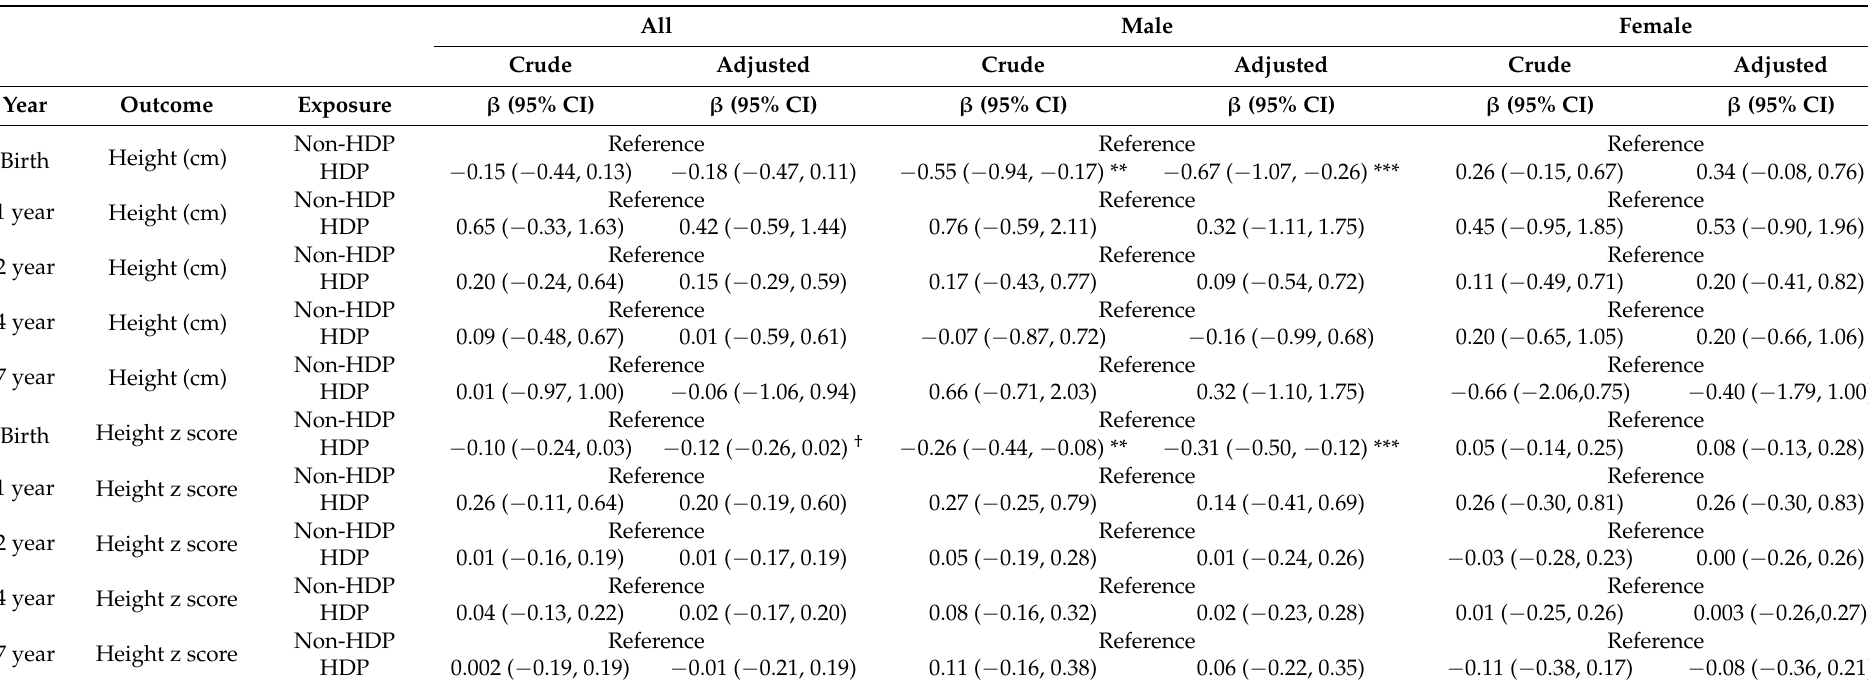
Table 5. Association between hypertensive disorders during pregnancy and height during different ages using the multiple linear regression